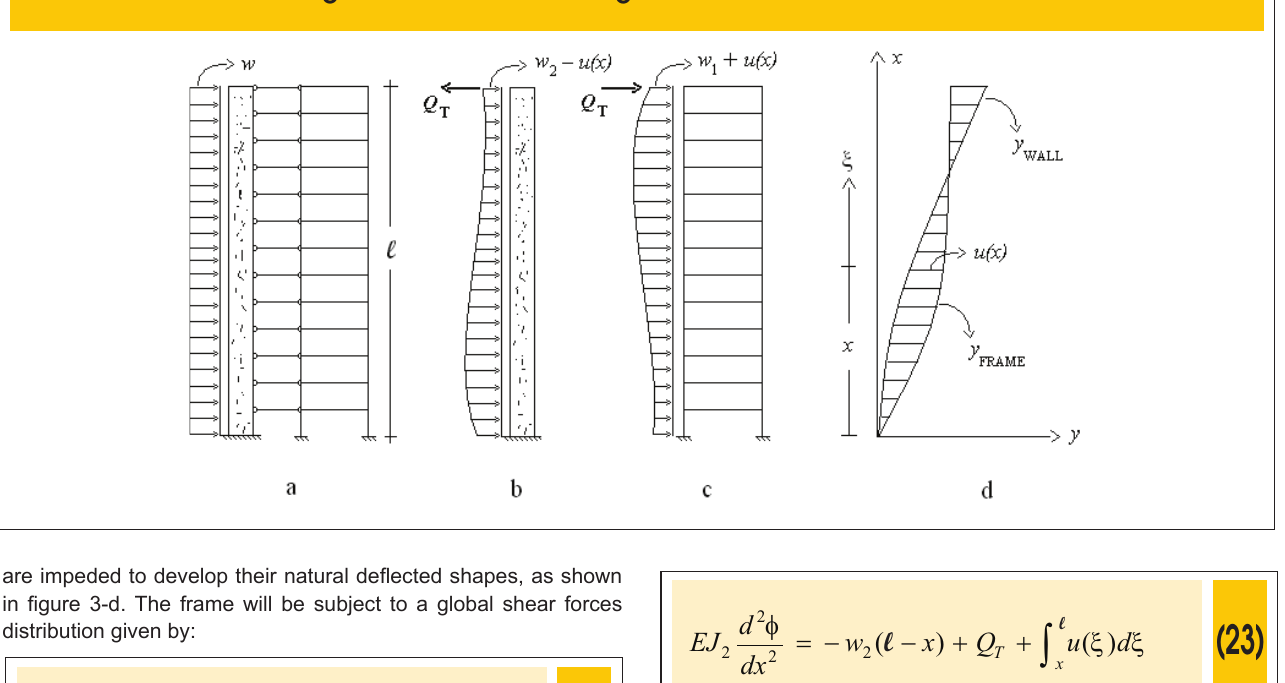
Figure 3 – Association of rigid frames with walls or